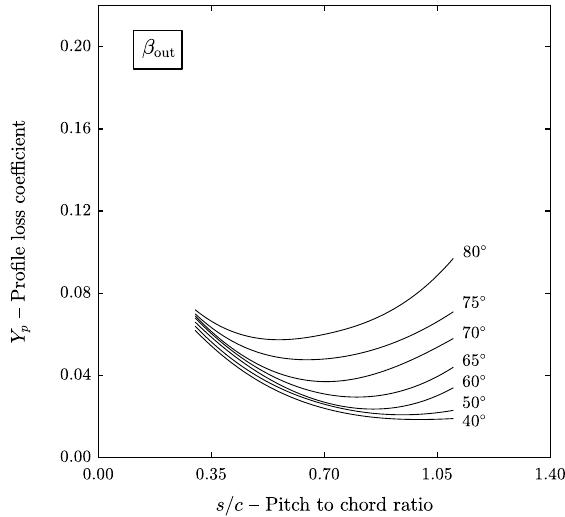
Figure A1. Profile loss of reaction blades (axial entry blades).